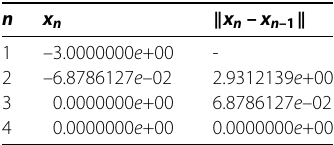
Table 1 Numerical results of Example 3.5 for the algorithm